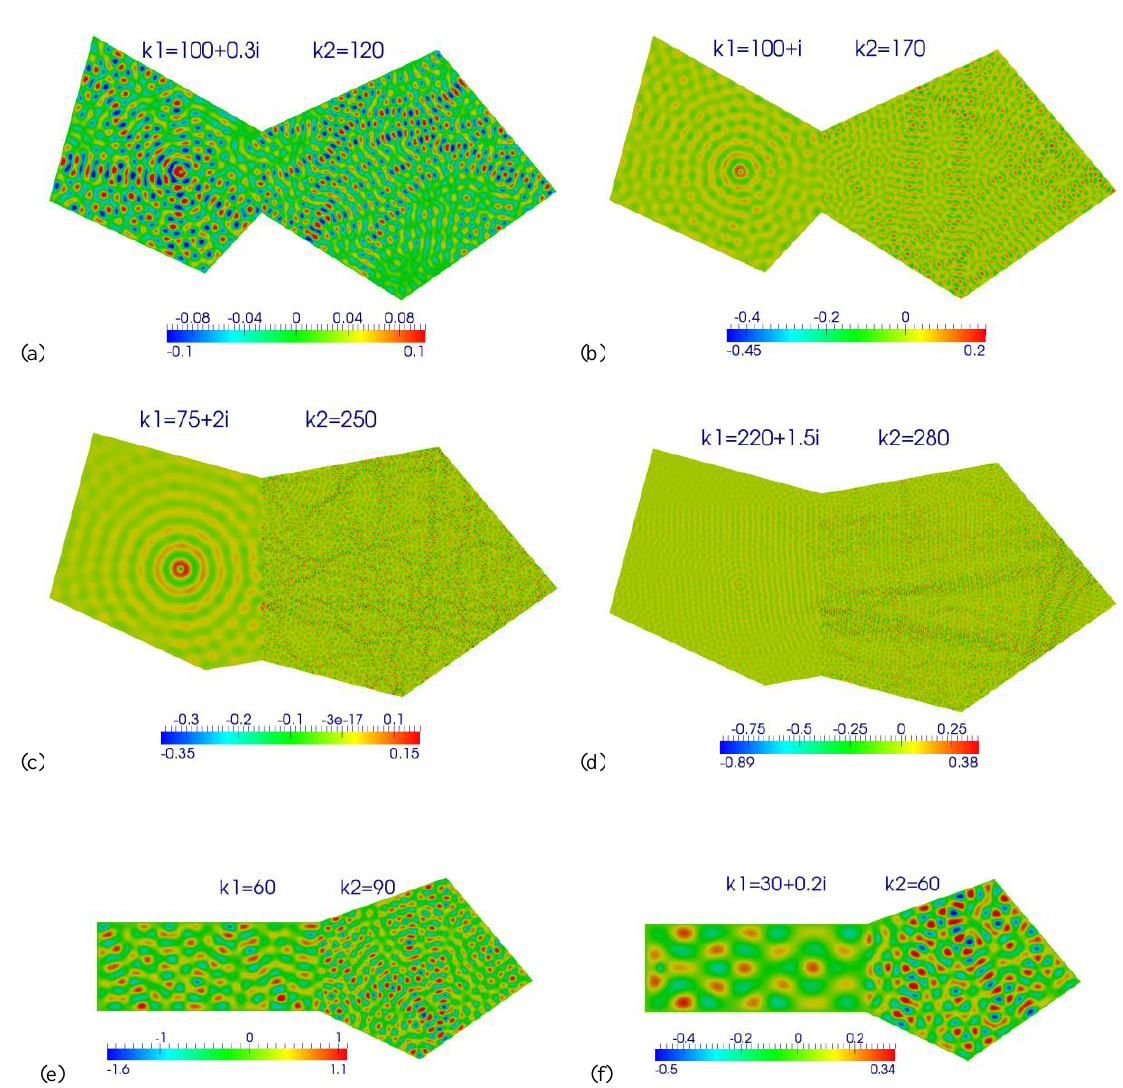
( ( , ; )) G k  r r of configuration. A, B and C with different range of wavenumbers k , the imaginary part of k represents the damping of the